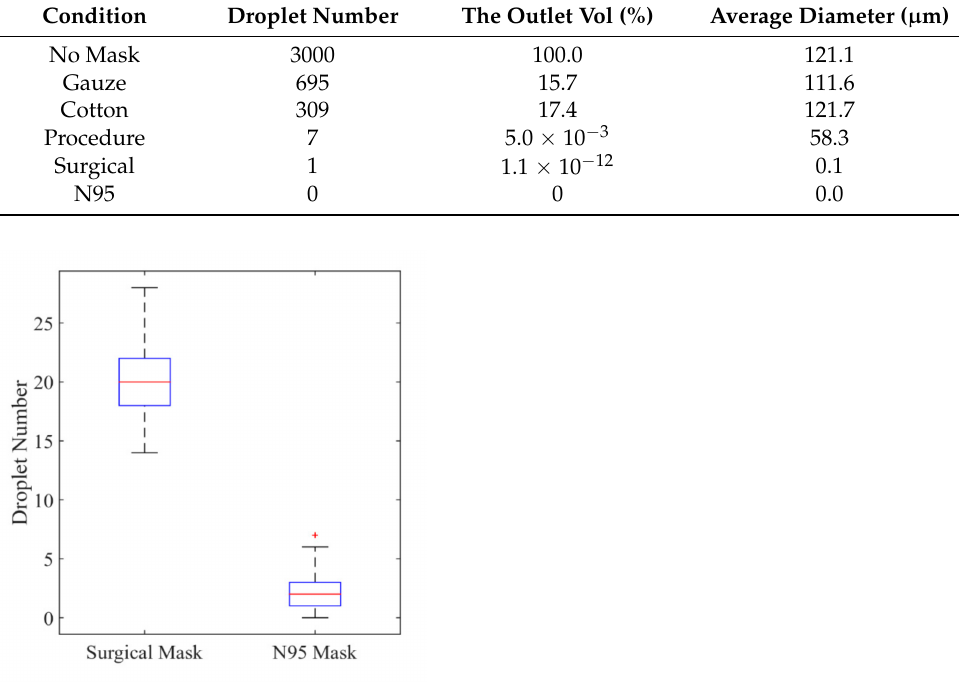
Figure 8. Box plot comparison of a surgical mask and N95 mask after 50 times running at additional droplet generator